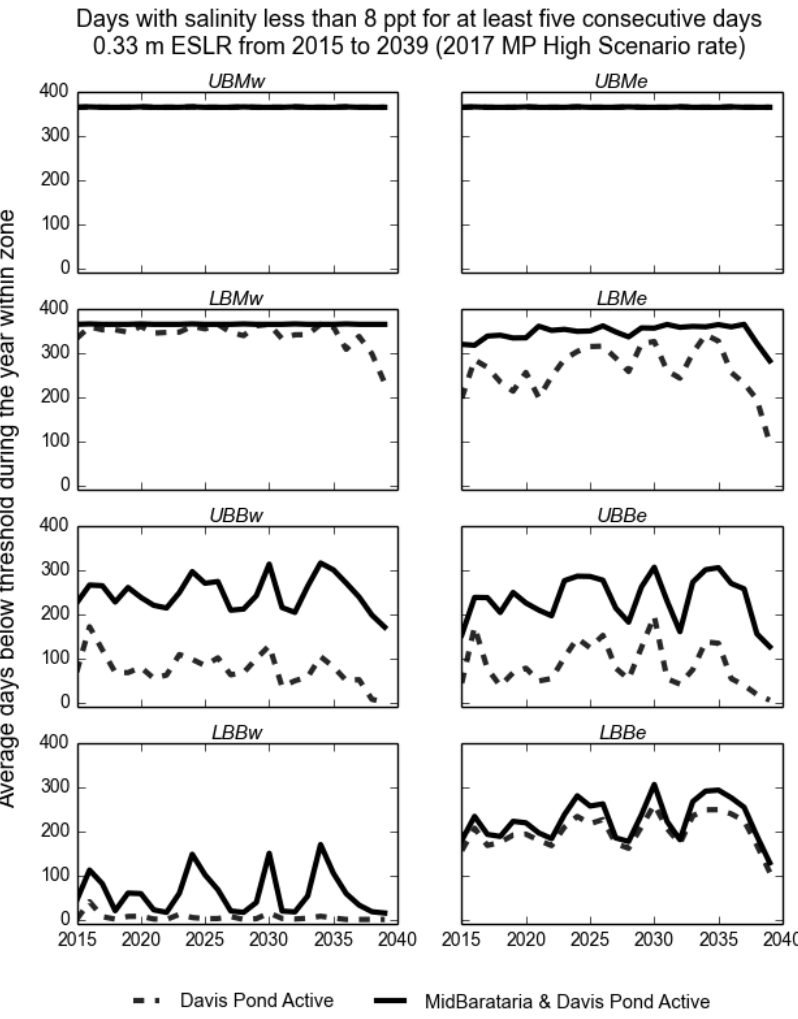
Figure 13. Mean number of days in a year for each zone where daily mean salinity was below 8 ng/kg for at least five consecutive days for two simulations under high sea level rise rates: only Davis Pond active (dashed), and both Davis Pond and Mid-Barataria diversions active.